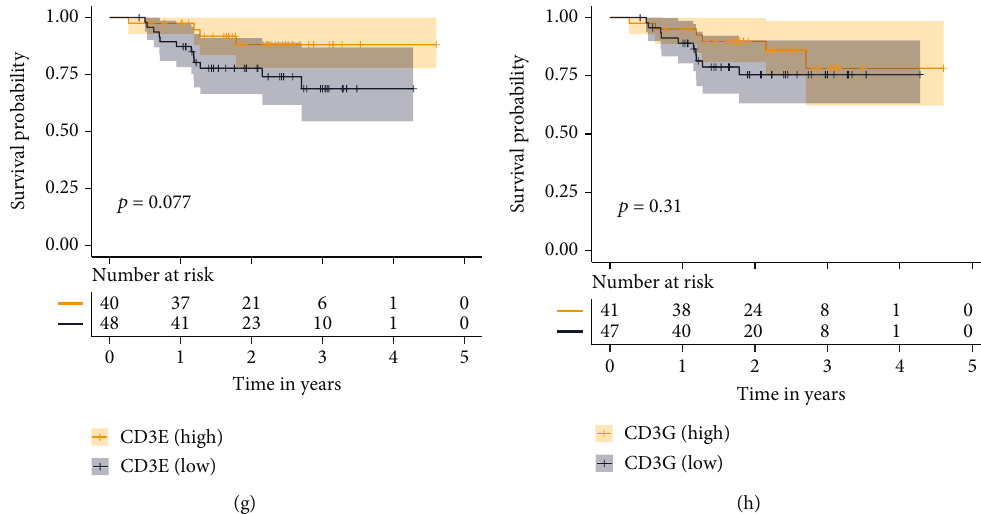
Figure 6: Hub-gene survival analysis. (a) – (h) Survival analysis of 8 hub genes divided according to the median value of their respective expression levels. p value < 0.05 was considered signi fi cant.